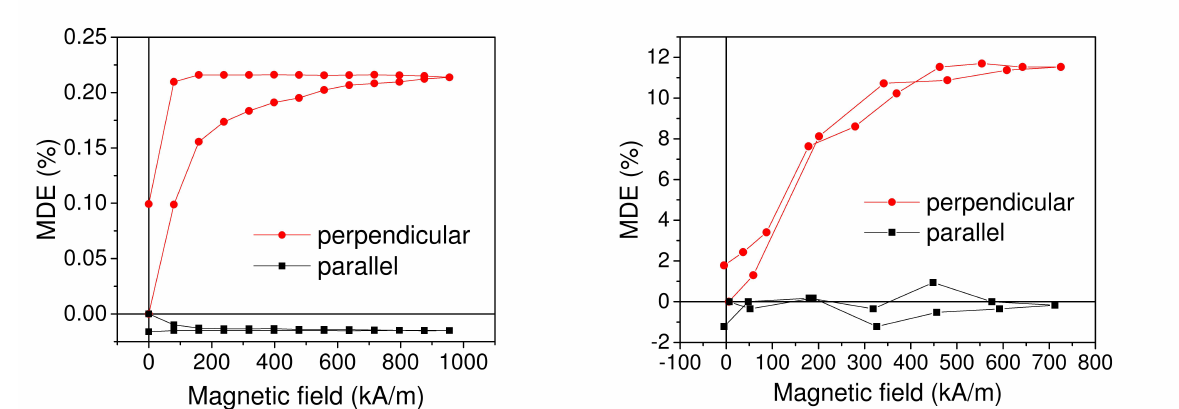
Figure 10. Comparison of simulated field dependence of MDE ( left ) with experimental data ( right ) for the magnetic field applied perpendicular and parallel to the capacitor plane. Simulation: Sample with 25% volume concentration of Fe, lognormal size distribution. Experiment: Sample with 25.3% volume concentration of Fe. Model showed good qualitative